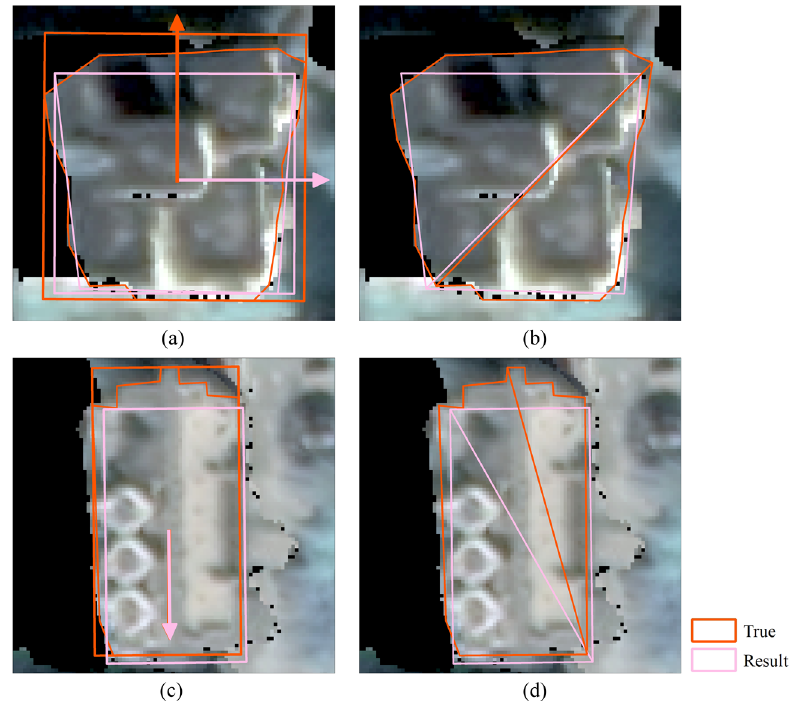
Figure 9. Two cases of the angle between OSM after registration and true building polygons com- puted by MMB method ( in the left column ) and TPMD method ( in the right column ). In ( a , c ), there are MBBs and the shapes of the true building polygons in red and the OSM after registration in pink, while the arrows are the normal vectors of the long sides in the MBBs with the same color. In ( b , d ), there are the shapes of the true building polygons and the OSM after registration, and the lines connecting the boundary points with the maximum distance.